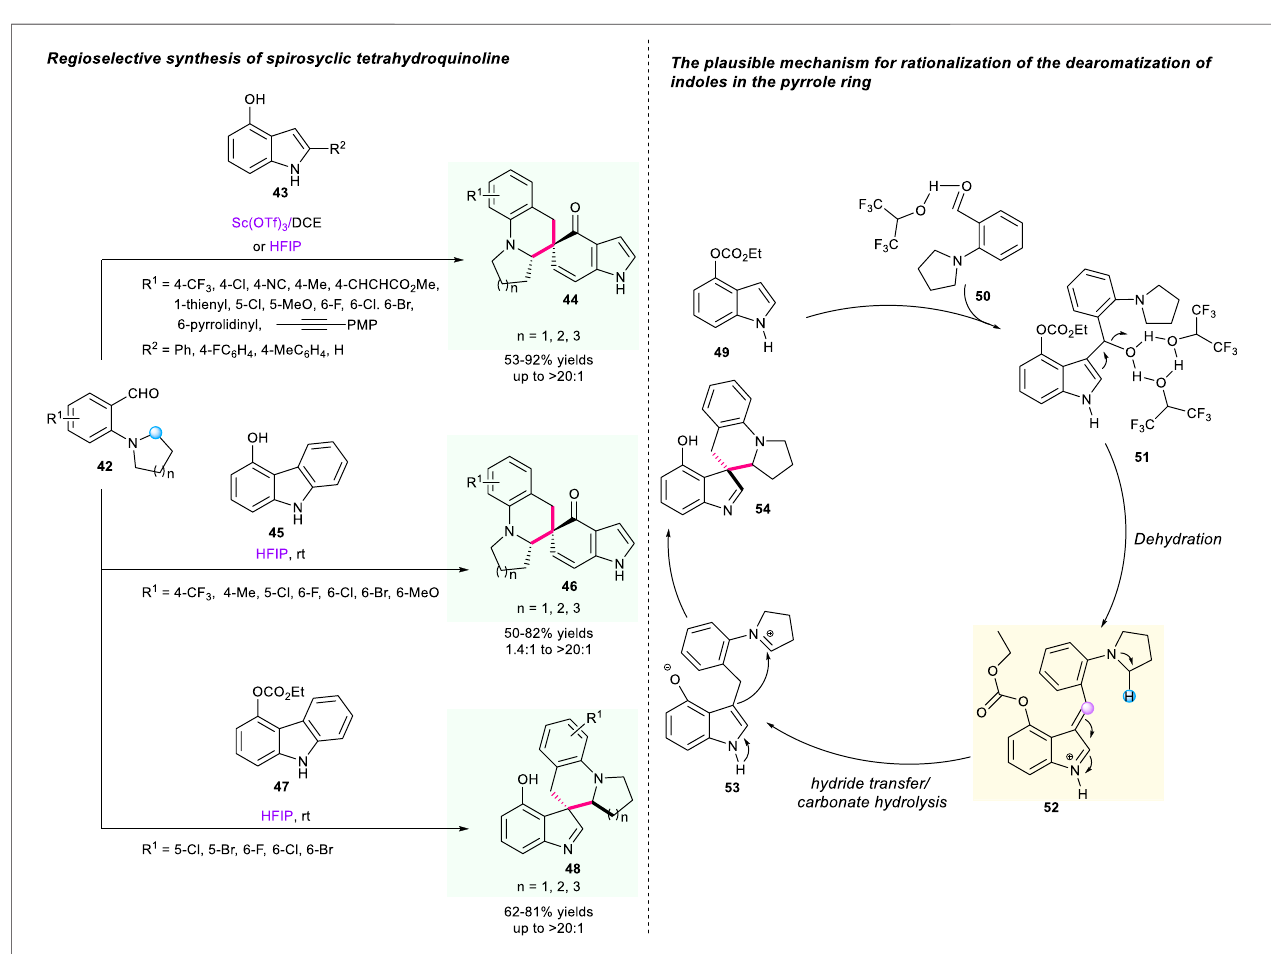
Frontiers in Chemistry |